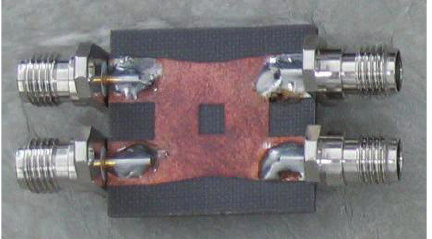
Figure 4: Photograph of a proposed nonuniform branch line